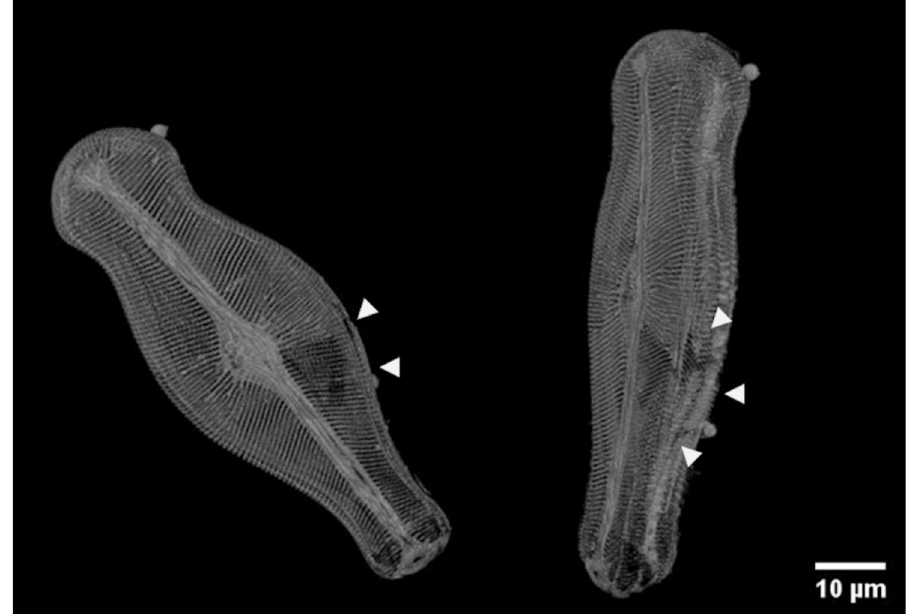
Figure 10. Visualization of D. geminata frustule obtained based on data from two separate tomography data sets: top and bottom of the frustule; arrowheads: voids due to the connection of two tomography data sets.